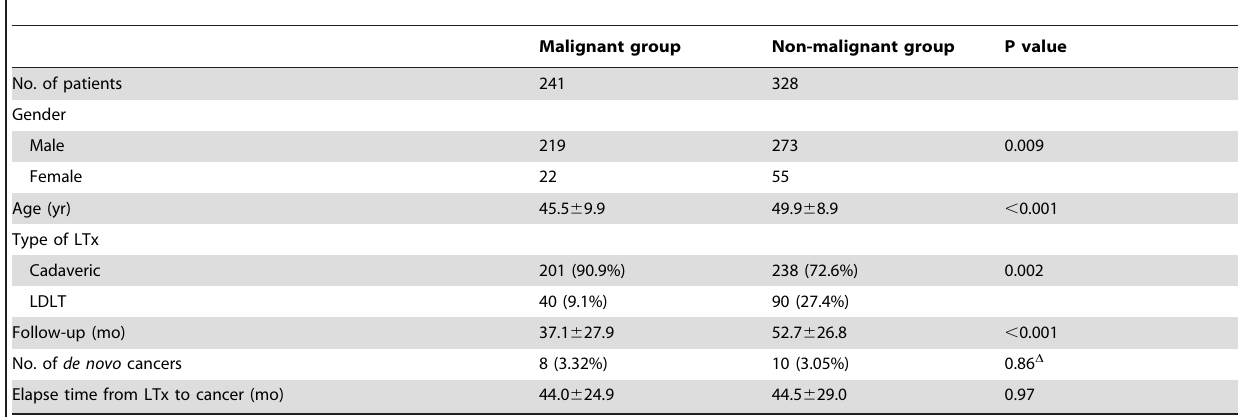
Table 1. Clinical details and de novo cancer incidences in recipients who underwent LTx for primary diagnosis of malignant and non-malignant disease.